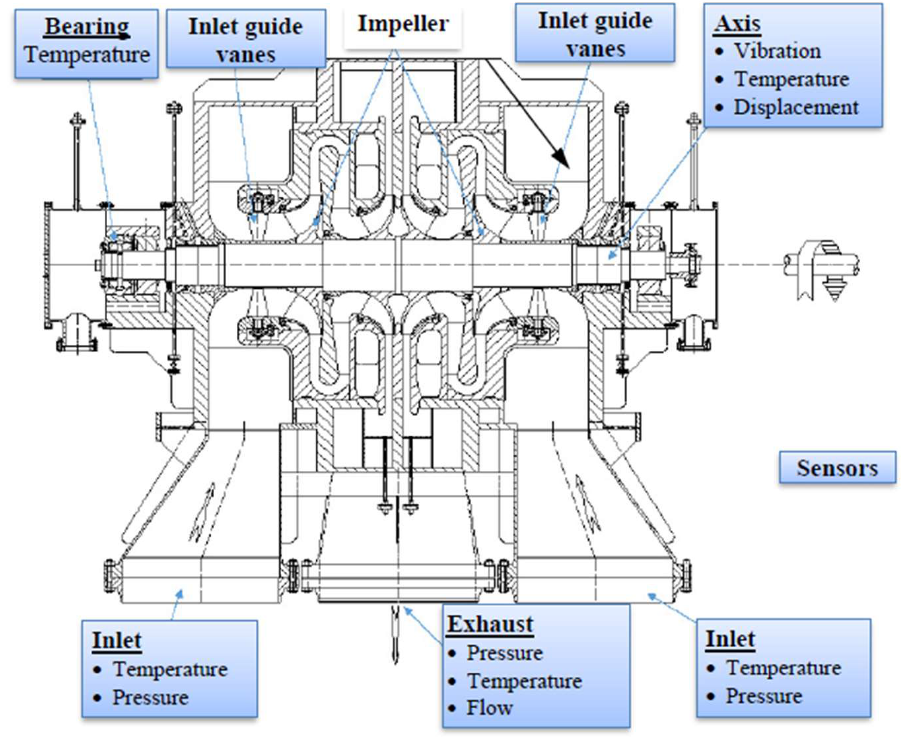
Figure 9. Diagram of sensors used to acquire time-series data from a centrifugal compressor.